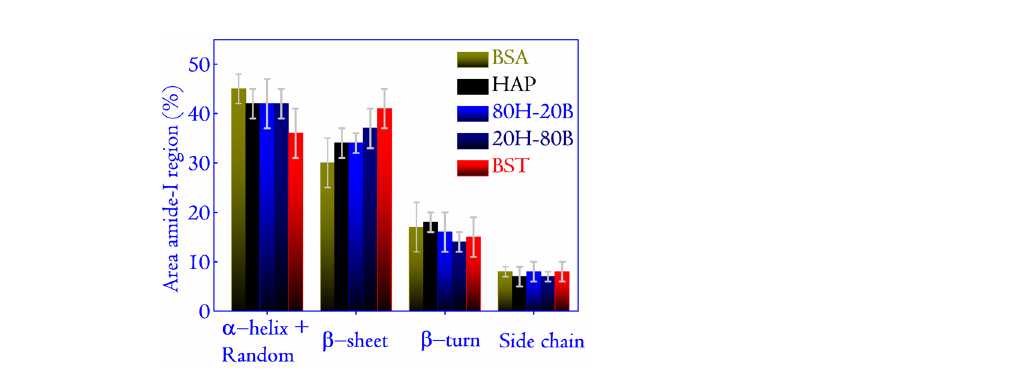
Figure 10. The variation in the content of secondary structures of BSA (in %) for various surfaces considered for protein adsorption. The content of secondary structurs are obtained by deconvoluting each of the FTIR spectra in Fig. 9 and the deconvoluted graphs are shown in Supplementary File S1 in Fig.